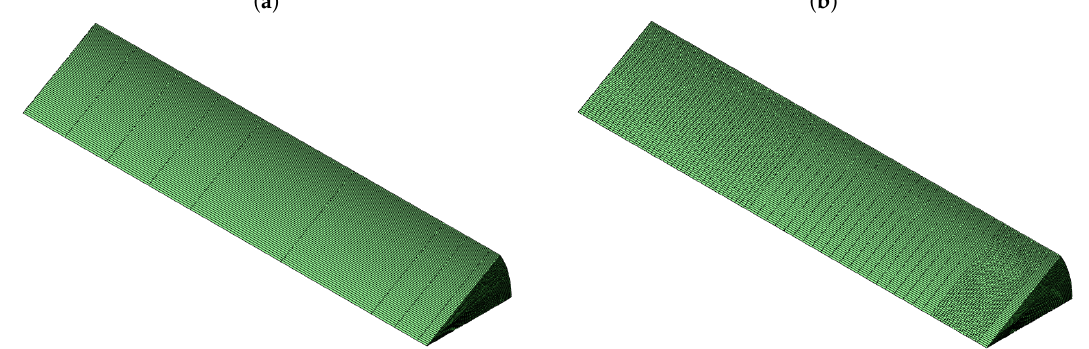
Figure 17. ( a ) Coarser mesh with l = 0.75 mm and ( b ) Finer mesh with l = 0.075